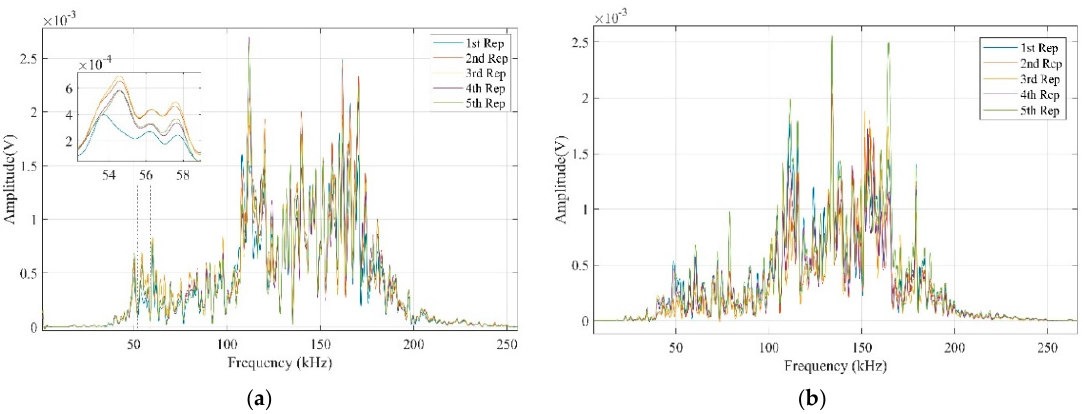
Figure 3. ( a ) Frequency spectrum of the chirp signals sent in the first position; ( b ) frequency spectrum of the chirp signals sent in the second